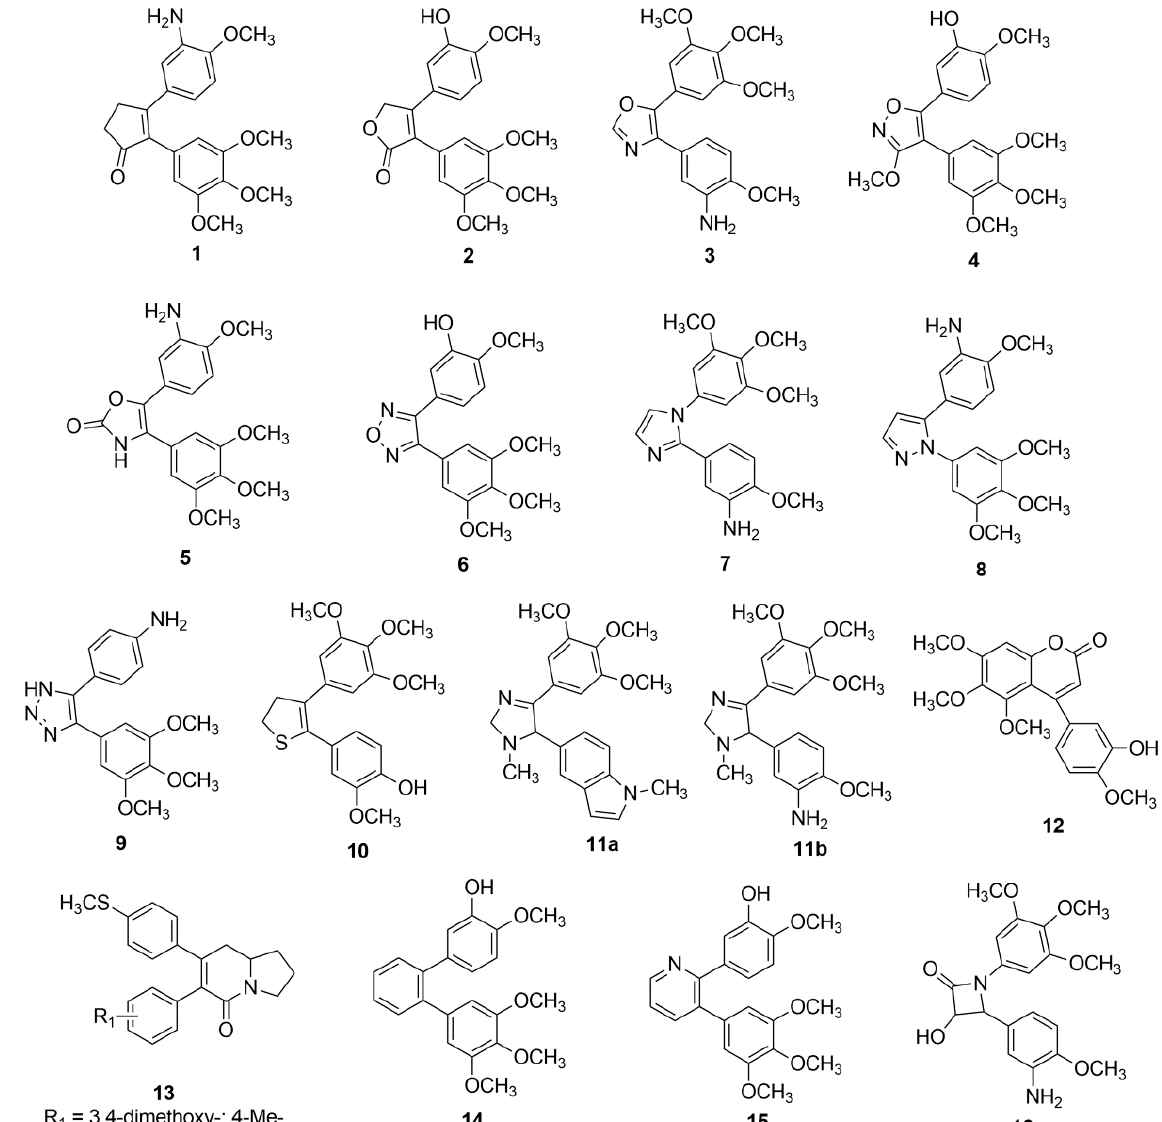
Figure 1. Selected cis -restricted stilbene-like analogs endowed with biological activity. Further optimization of the structural diversity of stilbenes to increase their potency and biological activity has been explored. In this context, several cis -locked stilbene-based compounds with vicinal 4-fluorophenyl/4-pyridine rings were designed, synthesized, and evaluated as inhibitors of p38 α mitogen-activated protein kinase (MAPK). The mitogen-activated protein kinases (MAPKs) are essential regulators for signal transduction pathways, involved in the control of cell functions including prolif- eration, gene expression, differentiation, mitosis, cell survival, and apoptosis [40]. The p38 MAP kinases are responsive to stress stimuli, such as ultraviolet irradiation, heat shock, osmotic shock, and mechanical stress; the abnormal activity of P38 is involved in